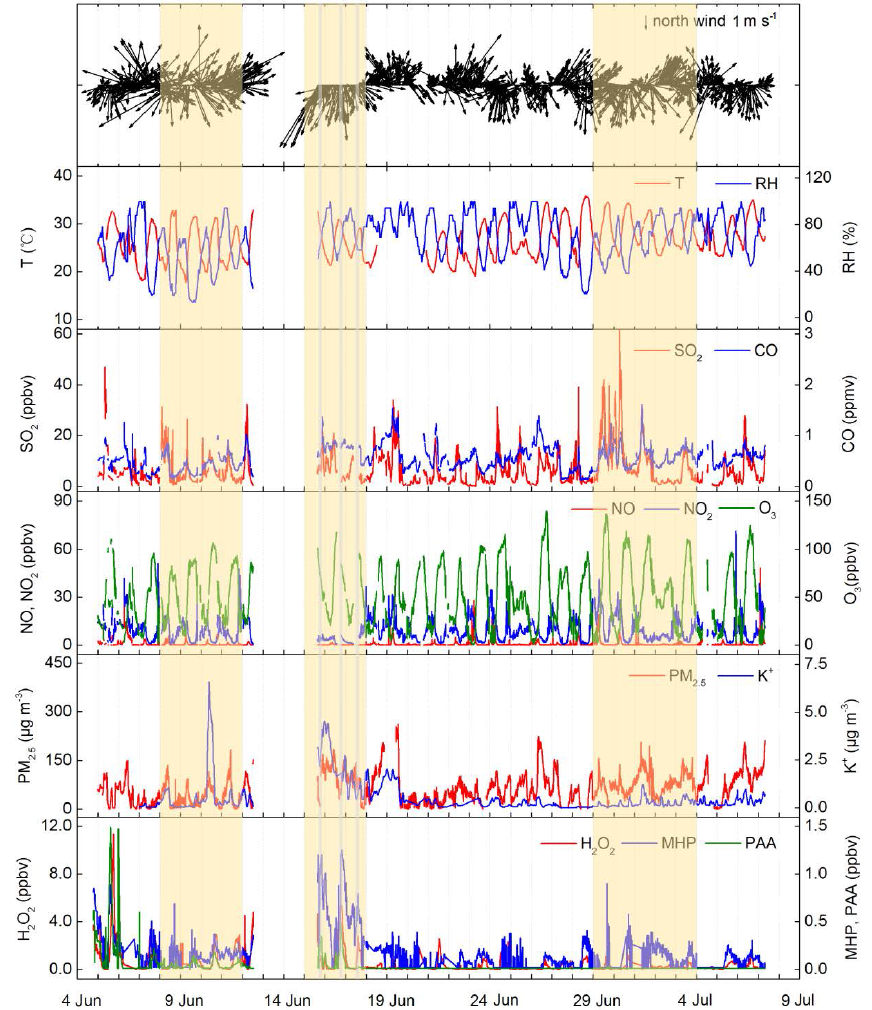
Figure 2. Time series of meteorological parameters, chemical species and atmospheric peroxides. The orange shaded area represents the Phase I (8–11 June), Phase II (15–17 June) and Phase III (29 June–3 July). The grey shaded area indicates three biomass burning